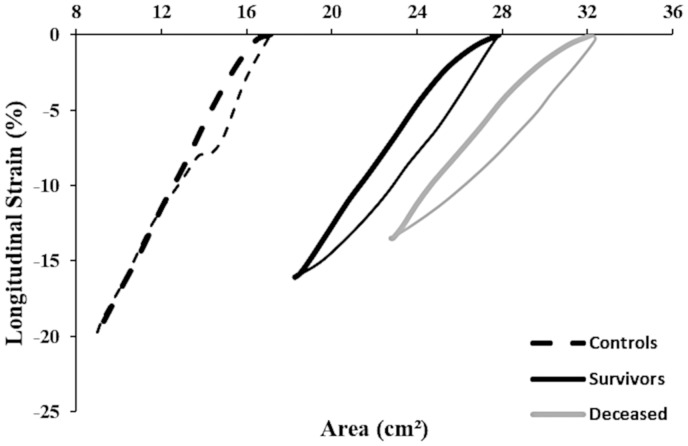
Mean RV ϵ-area loops taken at baseline (i.e. start of the follow-up period) from surviving patients (black ϵ-area loop, n = 98) and deceased patients (grey ϵ-area loop, n = 45). The dotted black lines represent the ϵ-area loop in a control group as published previously.8 The thick lines represents the systolic phase while the thin lines represent the diastolic phase of the ϵ-area loop.